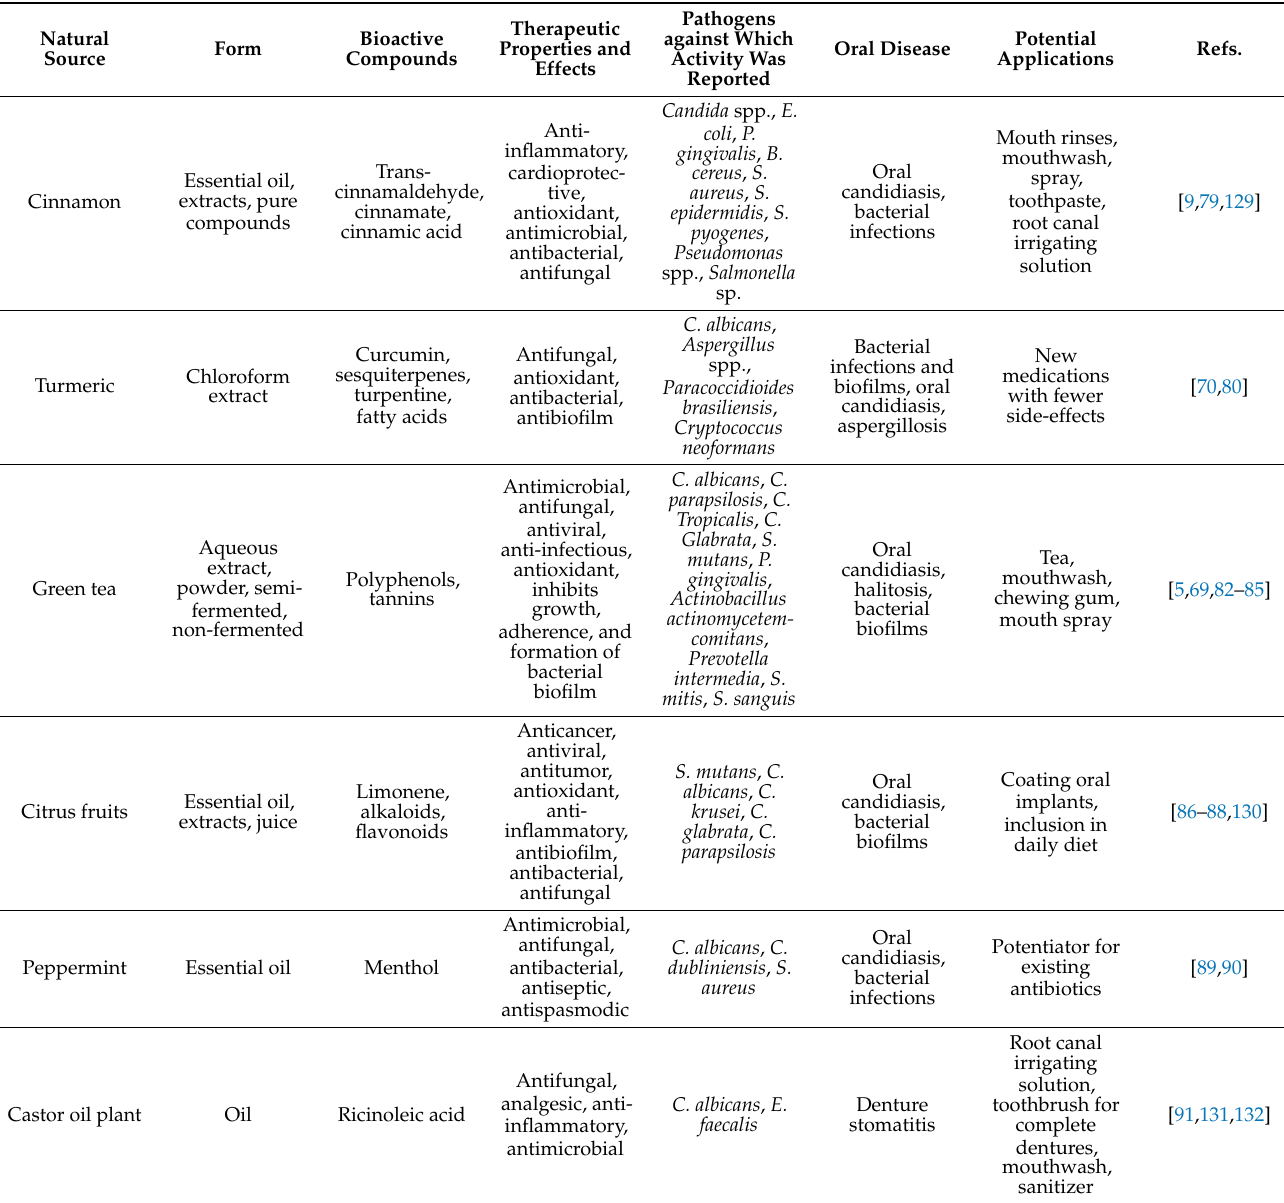
Table 3. Correlation between natural antimicrobial compounds, microorganisms, oral diseases, and potential applications. Natural Form Bioactive Compounds Source